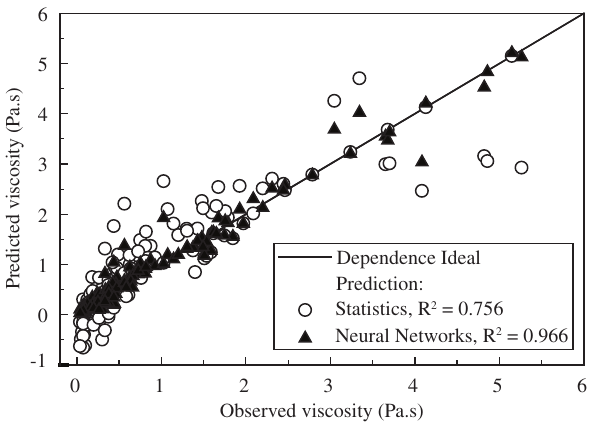
Figure 5. Considered neural network architecture.